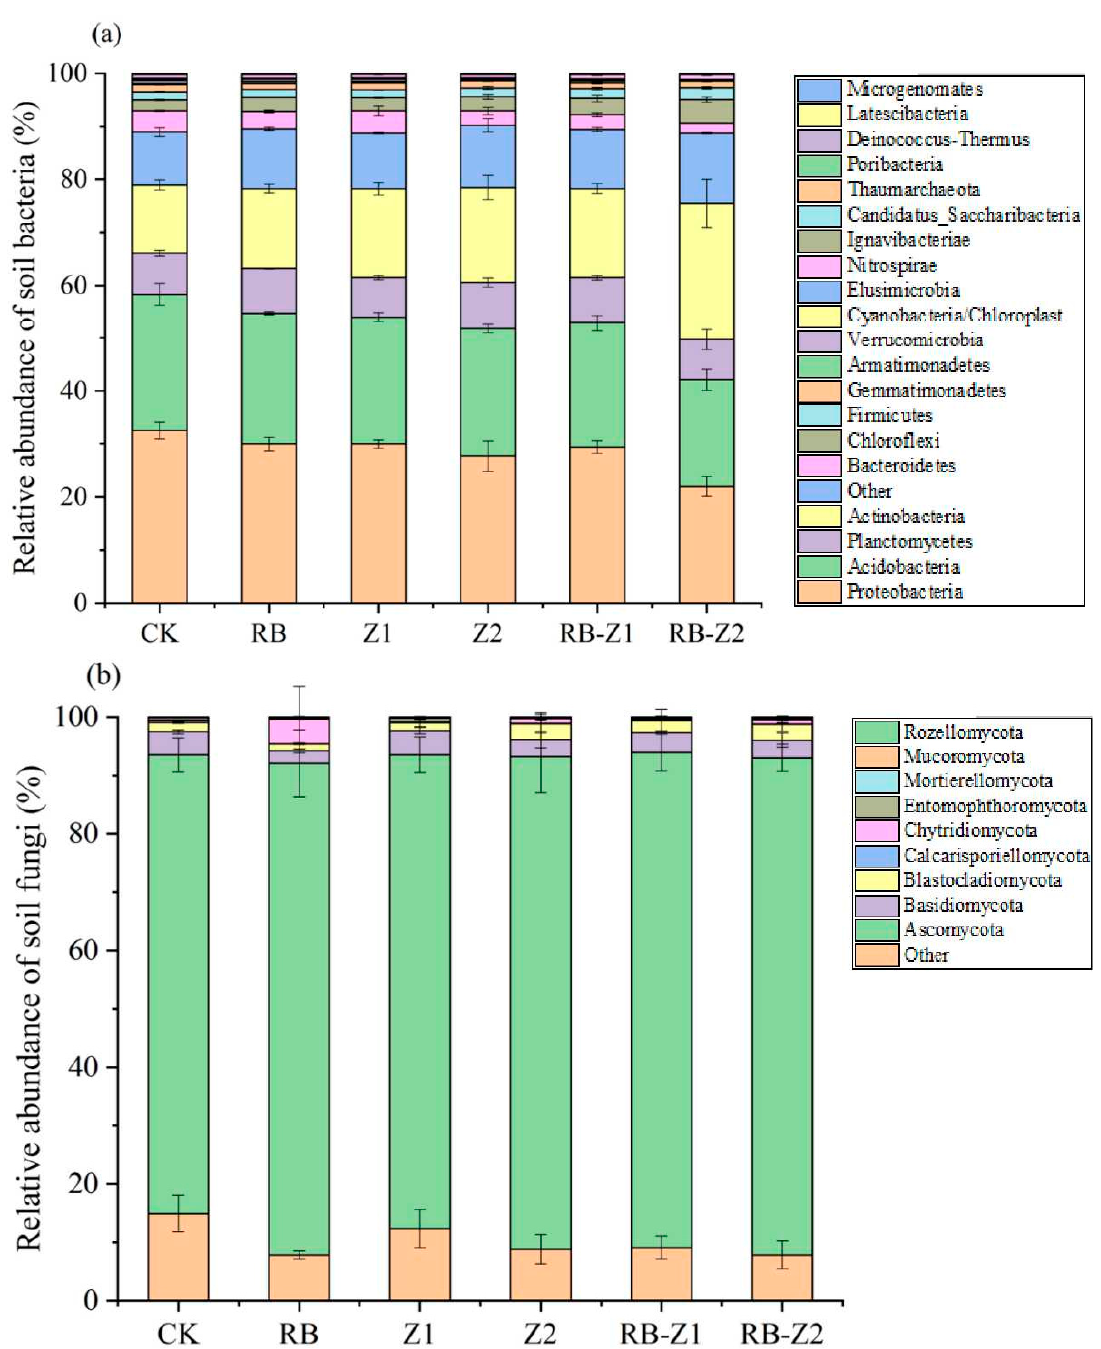
Figure 6. Community composition of ( a ) bacteria and ( b ) fungi at phylum lever in each treatment. The data are means ± SD, n = 3.